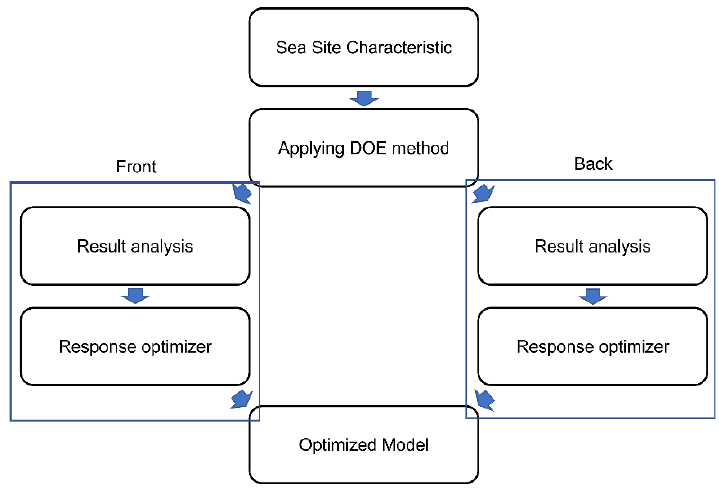
Figure 2. The Optimisation Process of the Hybrid BBDB-PA.